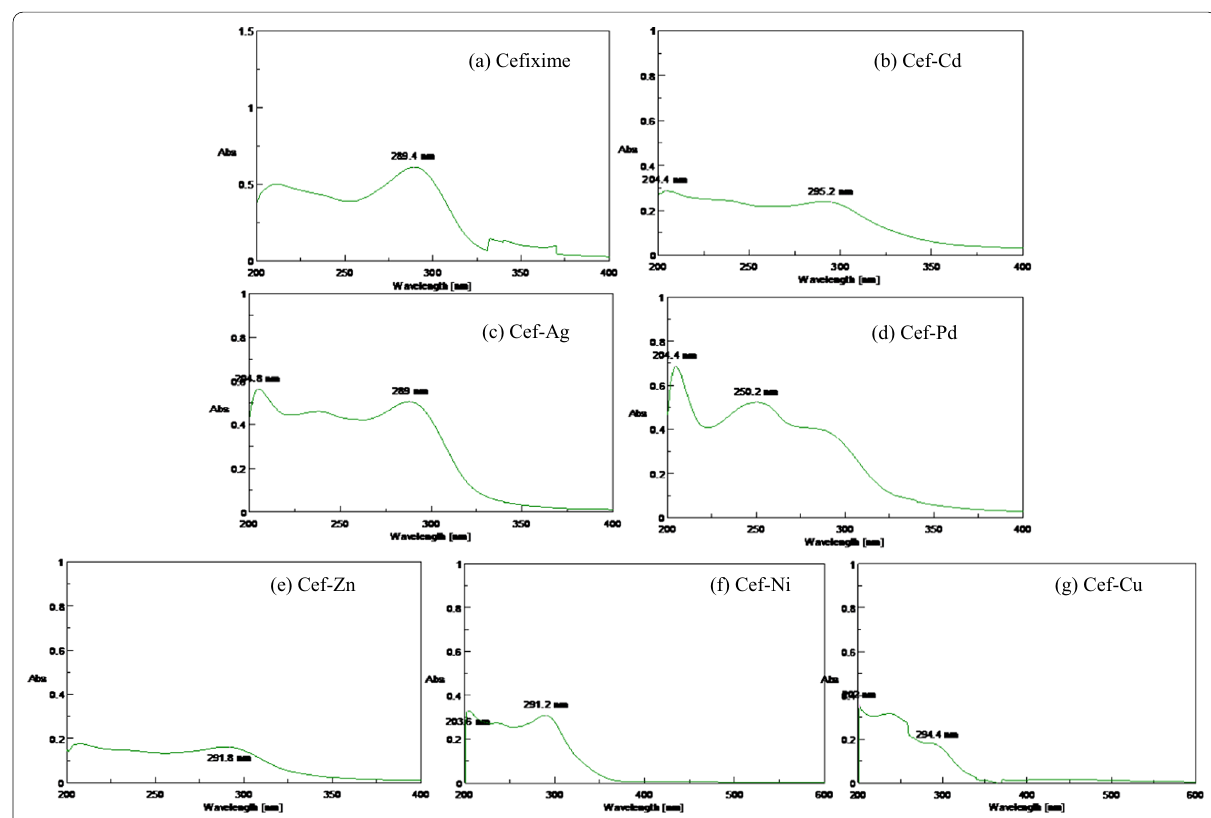
Fig. 2 UV spectrum in methanol a Cefixime, b Cef-Cd, c Cef-Ag, d Cef-Pd, e Cef-Zn, f Cef-Ni and g Cef-Cu